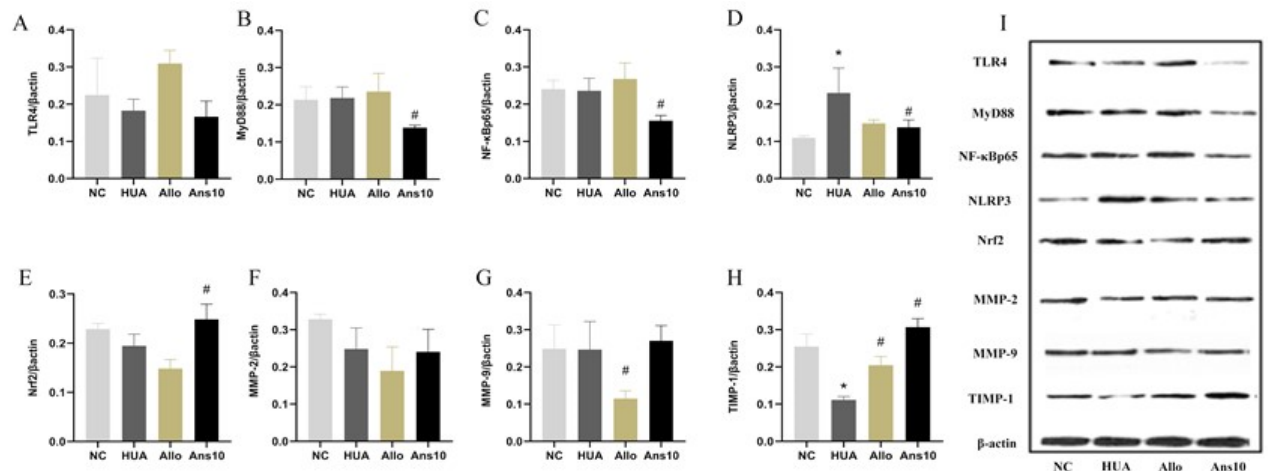
Figure 4. Effect of anserine on the TLR4/MyD88/NF- κ B pathway, NLRP3 inflammasome, Nrf2, and MMP-2, MMP-9, and TIMP-1. The relative expression of: ( A ) TLR4; ( B ) MyD88;( C ) NF- κ Bp65; ( D ) NLRP3; ( E ) Nrf2; ( F ) MMP-2; ( G ) MMP-9; and ( H ) TIMP-1 among groups. (I) Western blot results of TLR4/MyD88/NF- κ Bp65/NLRP3/Nrf2/MMP-2/MMP-9/TIMP-1 proteins in each group. * p < 0.05 indicates that the difference is significant when compared to the NC group. # p < 0.05 indicates that the difference is significant when compared to the HUA group.